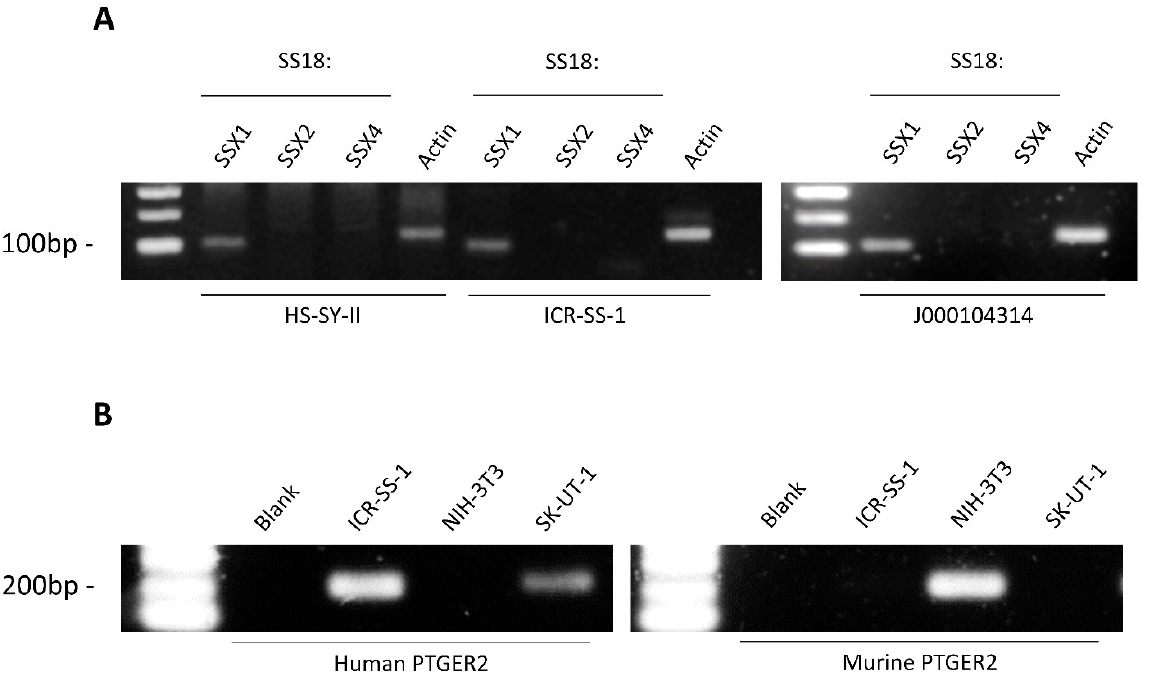
Figure 2. ( A ) PCR analysis of SS18::SSX1 , SSX2 , or SSX4 gene fusions in ICR-SS-1 cell line and J000104314 PDX tissue. The HS-SY-II cell line is used as a positive control. ( B ) PCR analysis of human and murine PTGER2 in ICR-SS-1 cell line. The NIH-3T3 cell line is used as a murine positive control and SK-UT-1 cell line as a human positive